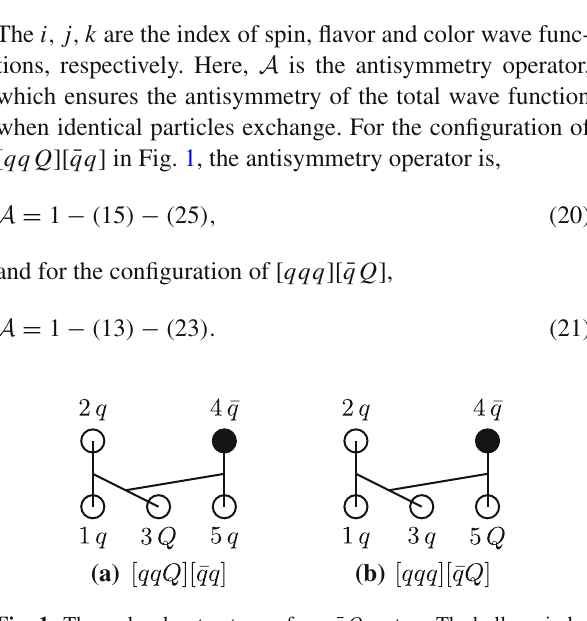
Fig. 1 The molecular structures of qqq ¯ qQ system. The hollow circles stand for quark and the black circle stands for